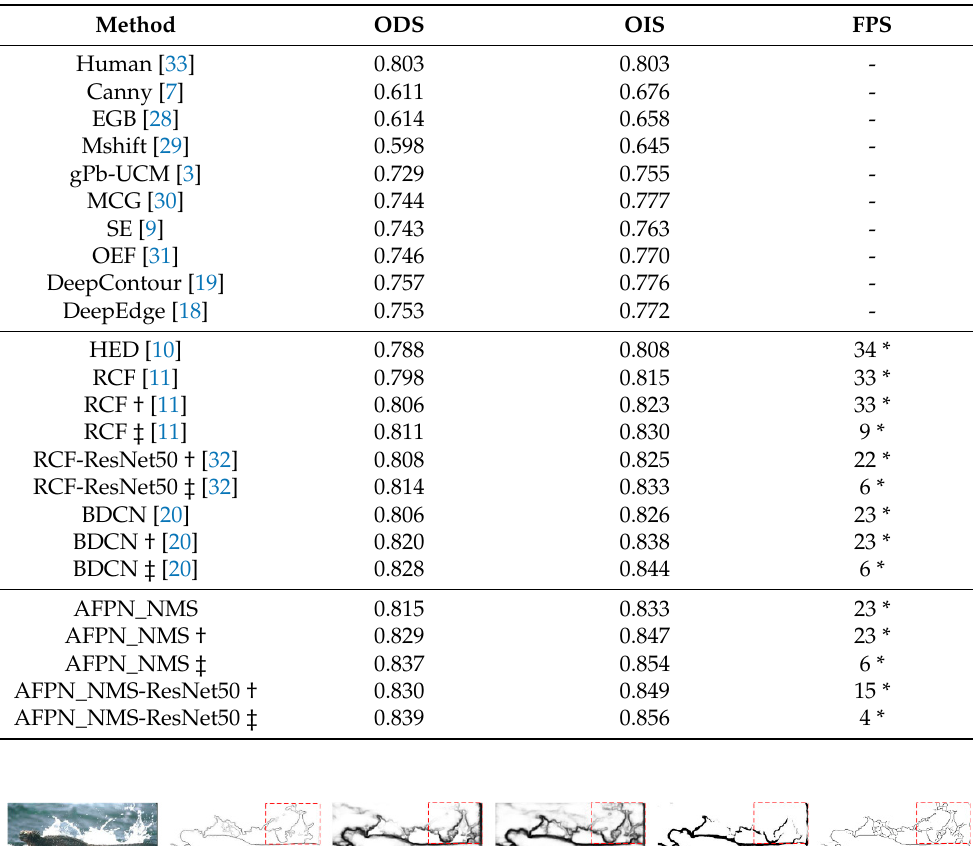
Table 1. Comparison with some competitors on the BSDS500 dataset. † indicates trained with additional PASCAL-Context data. ‡ indicates the fused result of multi-scale images. * means GPU time.